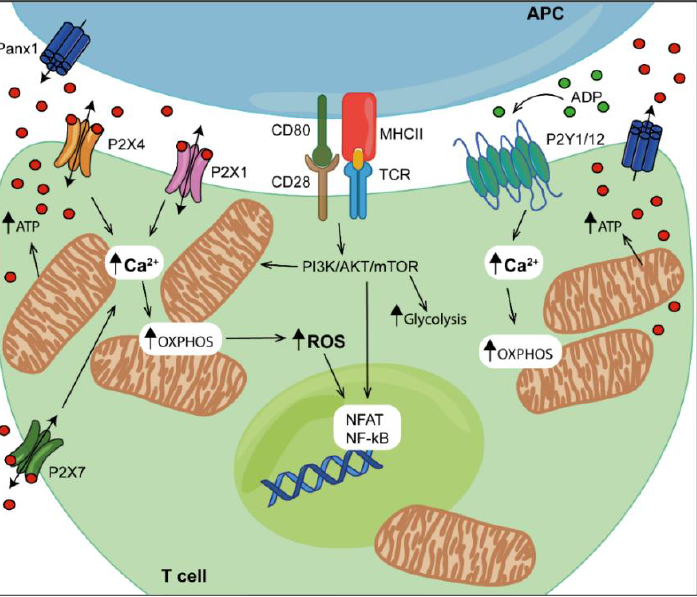
Figure 2. P2 receptors and mitochondria concur to support T-cell activation. Ligation of both T-cell receptor (TCR) and the costimulatory molecule CD28 increases glycolysis and mitochondrial metabolism through the phosphatidylinositol 3 kinase/Akt/mammalian target of rapamycin complex 1 (PI3K/AKT/mTOR) pathway and the downstream activation of transcription factors such as nuclear factor of activated T cells (NFAT) and nuclear kappa-light-chain-enhancer of activated B cells (NFkB). Upon antigen recognition, mitochondria are relocated to the immune synapse to sustain calcium signalling and supply local ATP, which is also partially released via pannexin 1 (panx-1) hemichannels. Extracellular ATP activates P2X1R, P2X4R and P2X7R, triggering a localized calcium influx that stimulates oxidative phosphorylation (OXPHOS) and mitochondrial respiration. Extracellular ATP is hydrolysed to ADP, which activates specific P2Y receptors such as P2Y 1 R and P2Y 12 R, boosting intracellular calcium signalling and mitochondrial ATP synthesis. Moreover, extra- cellular Ca 2+ influx and mitochondrial Ca 2+ uptake are required for reactive oxygen species (ROS) production and the modulation of ROS-dependent transcription factors NFAT and NF-kB. APC, antigen-presenting cell; panx-1,